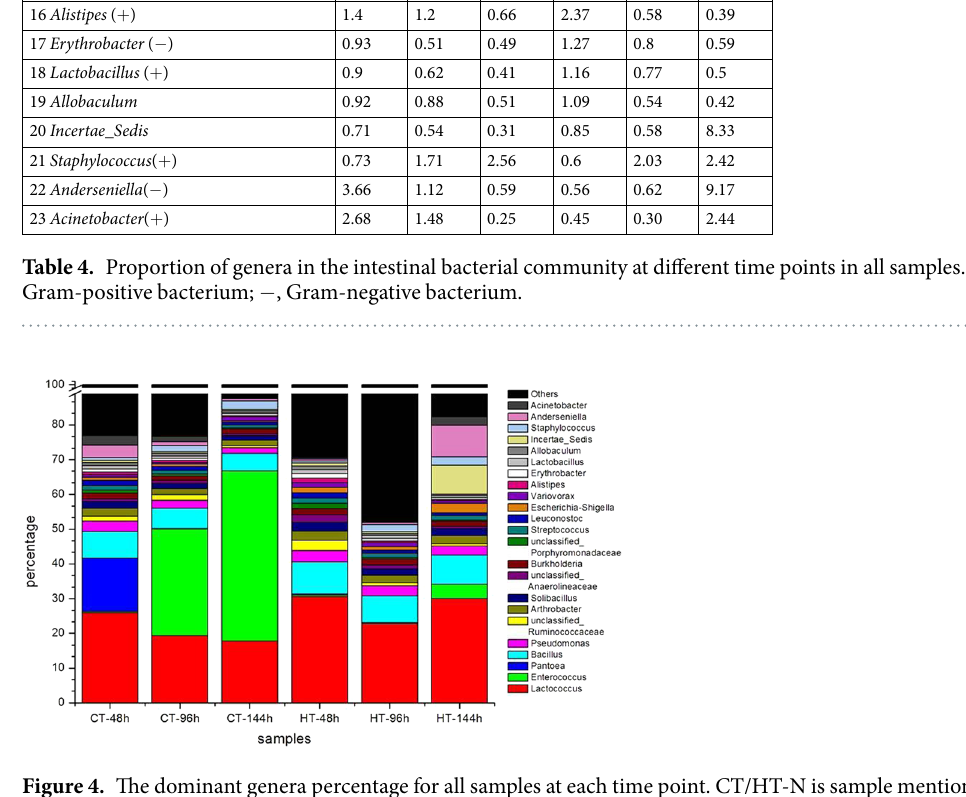
as the silkworm larvae matured or as time passed. In the HT-48 sample, the abundance of Pantoea , Anderseniella and Acinetobacter was decreased by 52.55, 6.54 and 5.96 times, respectively, compared to the control. The rich- ness of Acinetobacter and Anderseniella in the HT-96 sample was 4.93 and 1.81 times lower, respectively, than the control sample. In the HT-144 sample, the abundance of Acinetobacter , Anderseniella , Escherichia - Shigella and Incertae _ Sedis was 9.76, 15.54, 7.71 and 26.87 times higher, respectively, than the control sample. These results indicated that the silkworm gut flora was easily affected by the environmental temperature and that Enterococcus , Pantoea , Incertae _ Sedis , Escherichia - Shigella , Anderseniella and Acinetobacter were sensitive to transient high temperature (Table 4). Similarity of the intestinal flora in the control and THTT samples. The top 15 dominant genera were selected, and the similarity of microbial communities in the CT-48, CT-96, CT-144, HT-48, HT-96 and HT-144 samples was assessed using a distance matrix based on weighted-UniFrac distances. A heatmap displaying the similarity of bacterial populations in different samples was generated (Fig. 5a). The samples could be divided into two categories as follows: one class consisted of HT-48, CT-48, HT-96 and HT-144 with CT-48 and HT-48 being highly similar; and the other class consisted of CT-96 and CT-144. These categories indicated that the silkworm